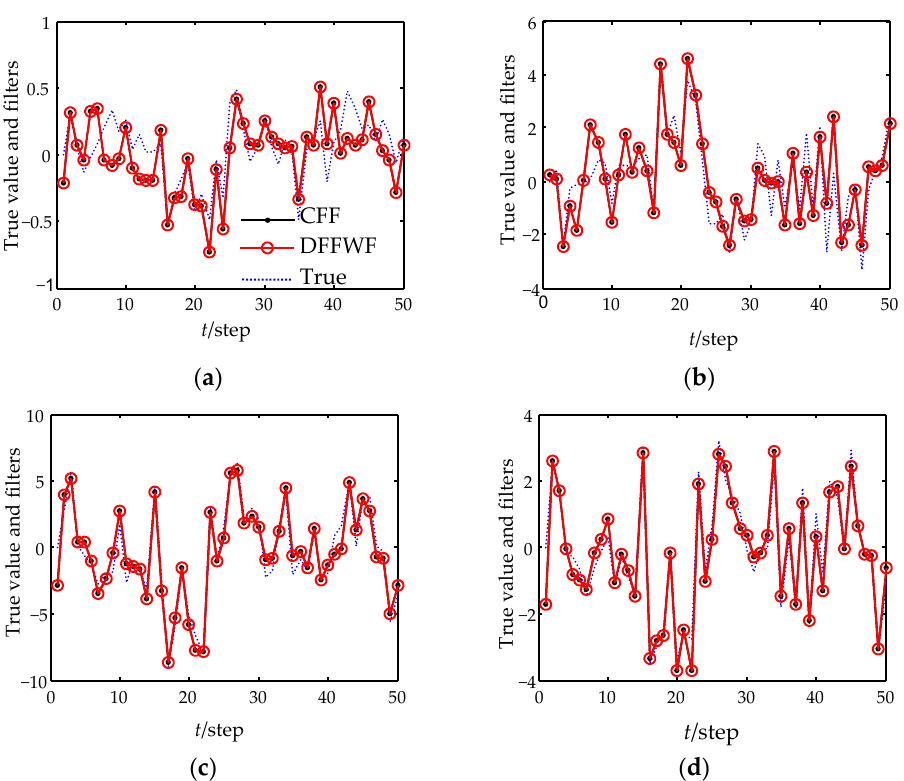
Figure 2. Tracking performance of DFFWF and CFF. ( a ) The first state component. ( b ) The second state component. ( c ) The third state component. ( d ) The fourth state component.